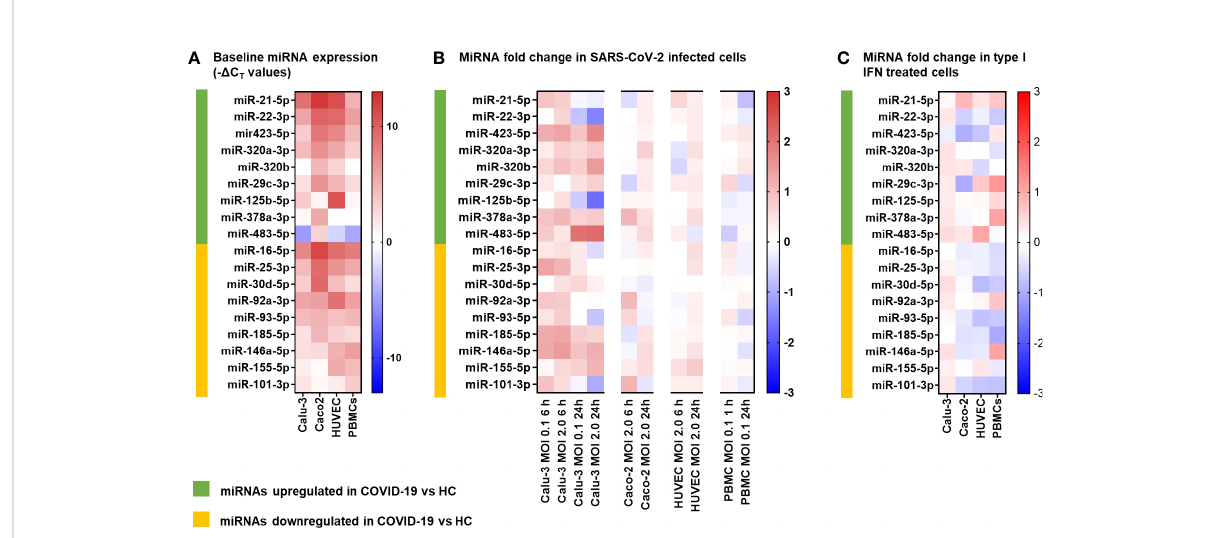
FIGURE 7 MicroRNA expression following SARS-CoV-2 infection and IFN a stimulation in different human cell types. The miRNAs investigated in vitro were selected among the differentially expressed (9 upregulated and 9 downregulated) serum miRNAs identi fi ed by the study in COVID-19 patients vs. healthy controls (HC). (A) Heatmap representing baseline miRNAs expression in lung carcinoma epithelial cells Calu-3, colon carcinoma epithelial cells Caco-2, human umbilical vein endothelial cells HUVEC, and peripheral blood mononuclear cells (PBMC). Data represent - D C T values of miRNA normalized to the endogenous control RNU6B in triplicate samples. The color scale bar represents - D C T values. (B) Heatmap representing miRNA fold change in cells infected with SARS-CoV-2 at MOI 0.1 or 2 vs. mock infected cells at 6 h and 24 h post infection. mRNA expression was measured by real-time RT-PCR and represented as mean log2 fold change vs. mock (calculated with the 2 - DD CT method) obtained from two experiments conducted in triplicate. The color scale bar represents mean log2 fold change vs. mock. (C) Heatmap representing miRNA fold change in cells treated for 24 h with IFN a 1000 U/mL vs. mock treated cells. mRNA expression was measured by real- time RT-PCR and represented as mean log2 fold change vs. mock (calculated with the 2 - DD CT method) obtained from two experiments conducted in triplicate. The color scale bar represents mean log2 fold change vs.